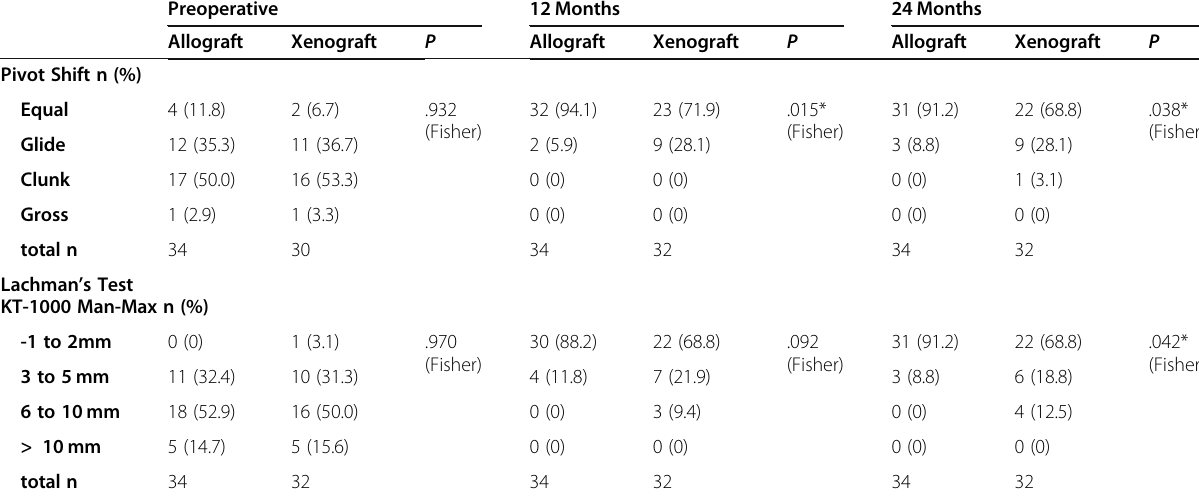
Table 3 Objective Knee Laxity Evaluation - Missing/Contaminated Graft Subjects Included (LOCF)